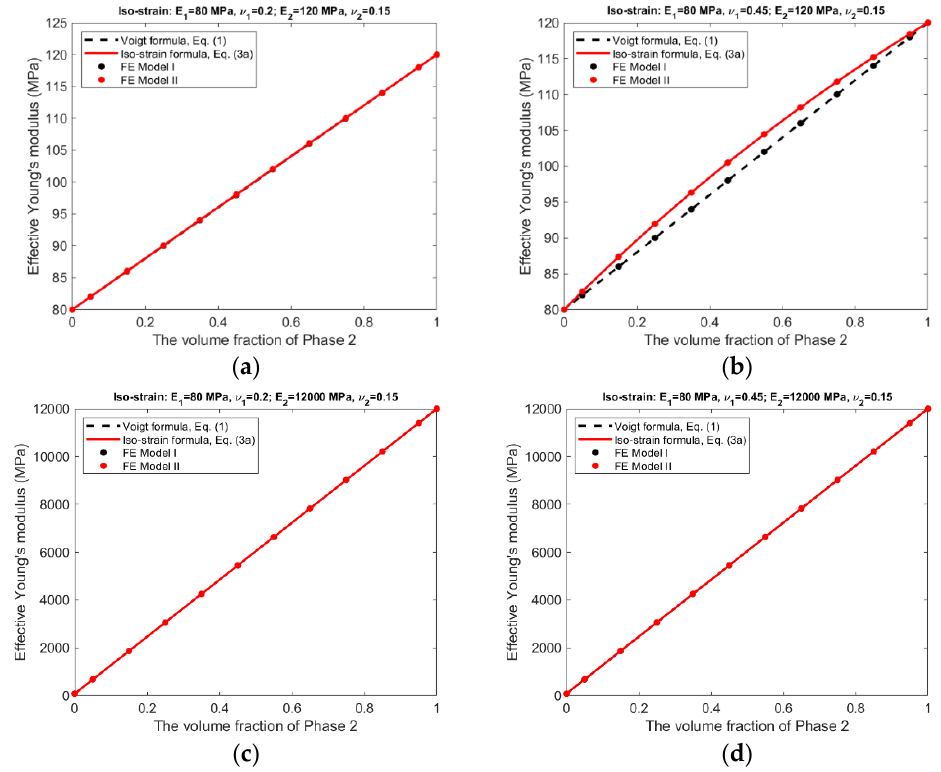
Figure 6. Iso-strain condition—Effective Young’s moduli predicted by analytical formulas and FEM.